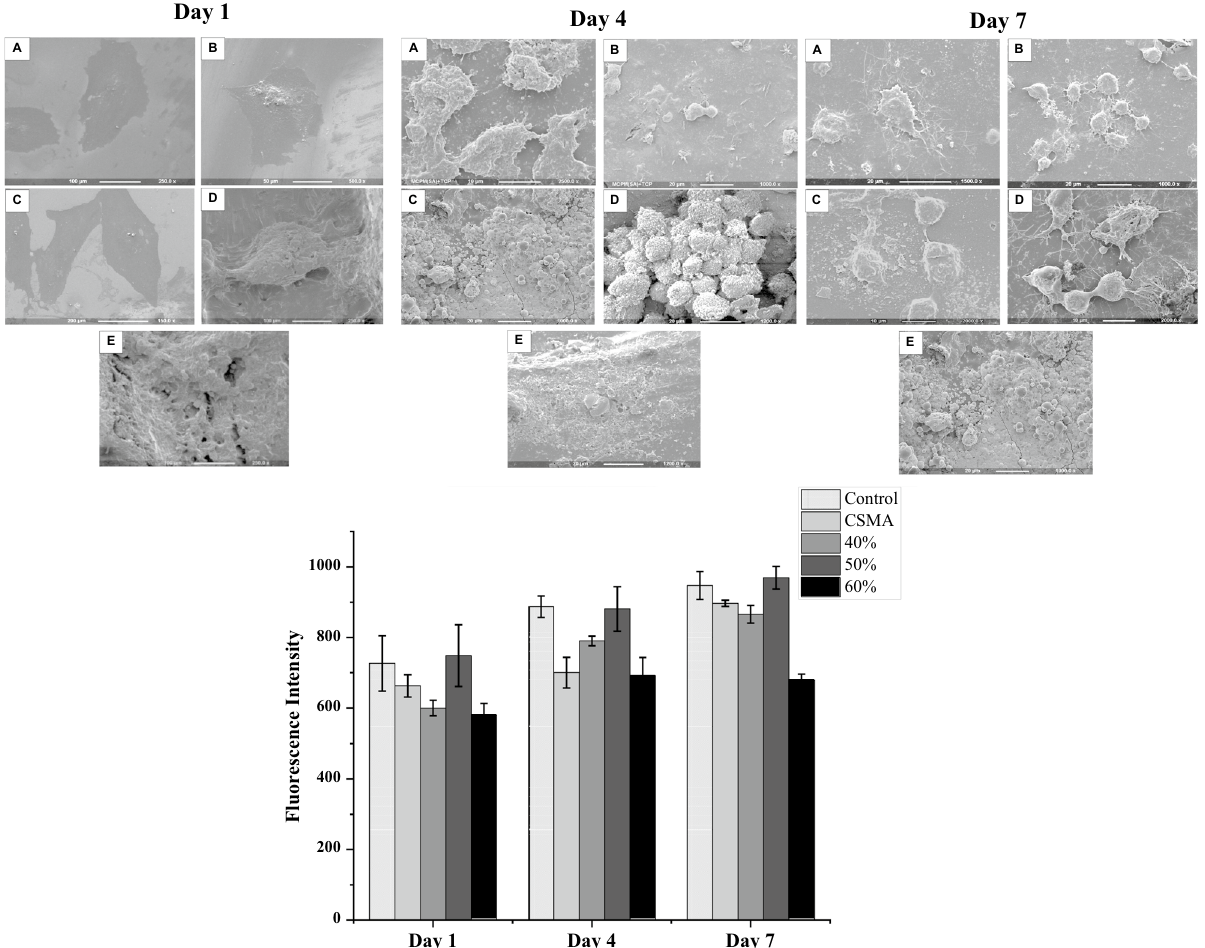
Figure 5. SEM images showing MC3T3 cell proliferation on the surface of control ( A ), CSMA ( B ), 40% CaP ( C ), 50% CaP ( D ) and 60% CAP ( E ) at 1-, 4- and 7-days post-incubation in culture media. Topographical changes can be observed as a function of surface remineralisation, this is particularly apparent at day 7 in D. A uniform layer of cells with clear morphology can also be seen at days 1 and 4 confirming spreading and integration of the cells throughout the surface of the polymer and CaP incorporated discs. Alamar blue metabolic activity of MC3T3 cells on polymer plus 40, 50 and 60% CaP composites, presented on left, shows 50% CaP disc and CSMA did not show any significant difference in the fluorescence intensity value compared to control. The lowest cell proliferation was observed in the 60% CaP disc with exhibiting significantly lower metabolic activity readings (p < 0.05) compared to the remaining discs, this was followed by 40%. The highest statistically significant formulations are presented with an asterisk on top of this